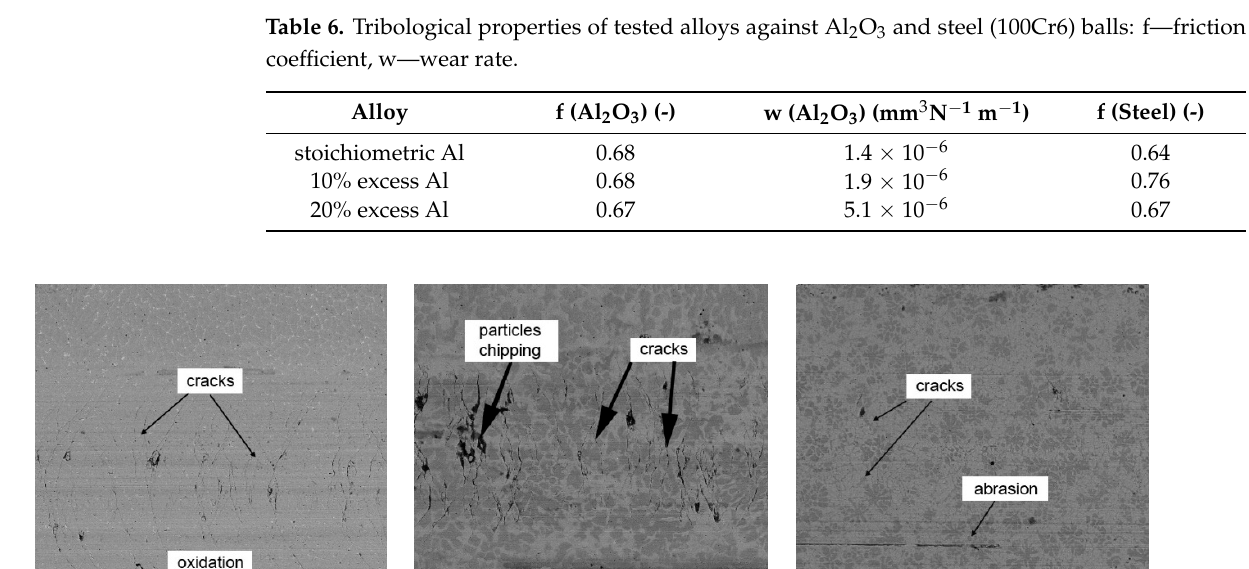
Figure 9. Wear tracks on aluminothermically prepared samples after testing with Al 2 O 3 ball as the static partner: ( a ) alloy reduced with stoichiometric amount of aluminum; ( b ) with 10% of aluminum excess and ( c ) with 20% of aluminum excess.